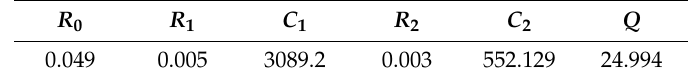
Table 4. Dual-polarization model (DPM) model parameter identification results.